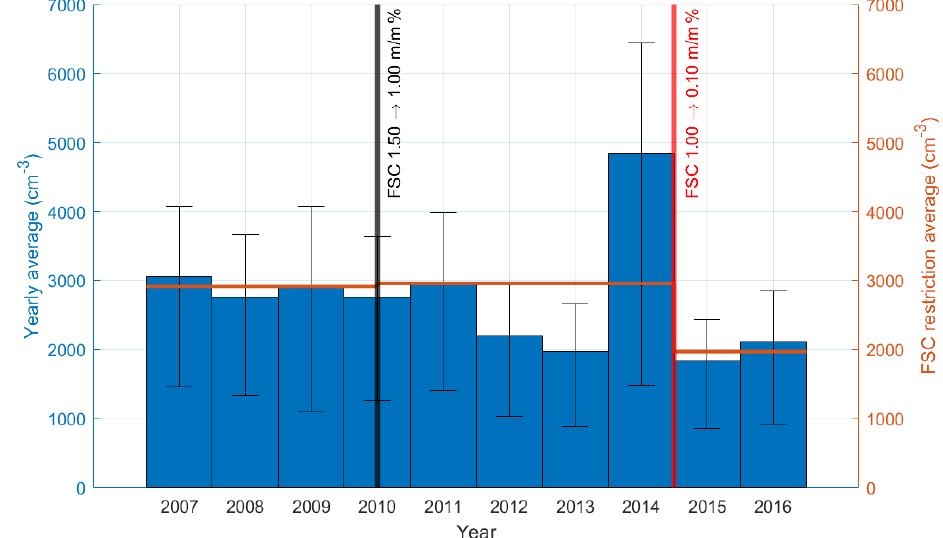
Figure 10. Annual average ambient particle number concentrations (PNC tot , blue bars) and the average PNC tot values (orange lines) during the different FSC restrictions. Changes in the FSC restrictions are marked with the black and red vertical lines. The 25th and 75th percentiles are marked with the black error